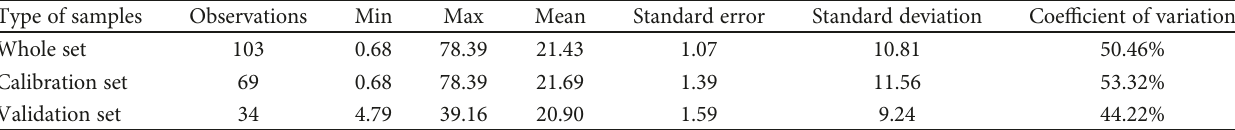
Table 1: The statistical characteristics of organic matter content of soil samples (g kg − 1 ).